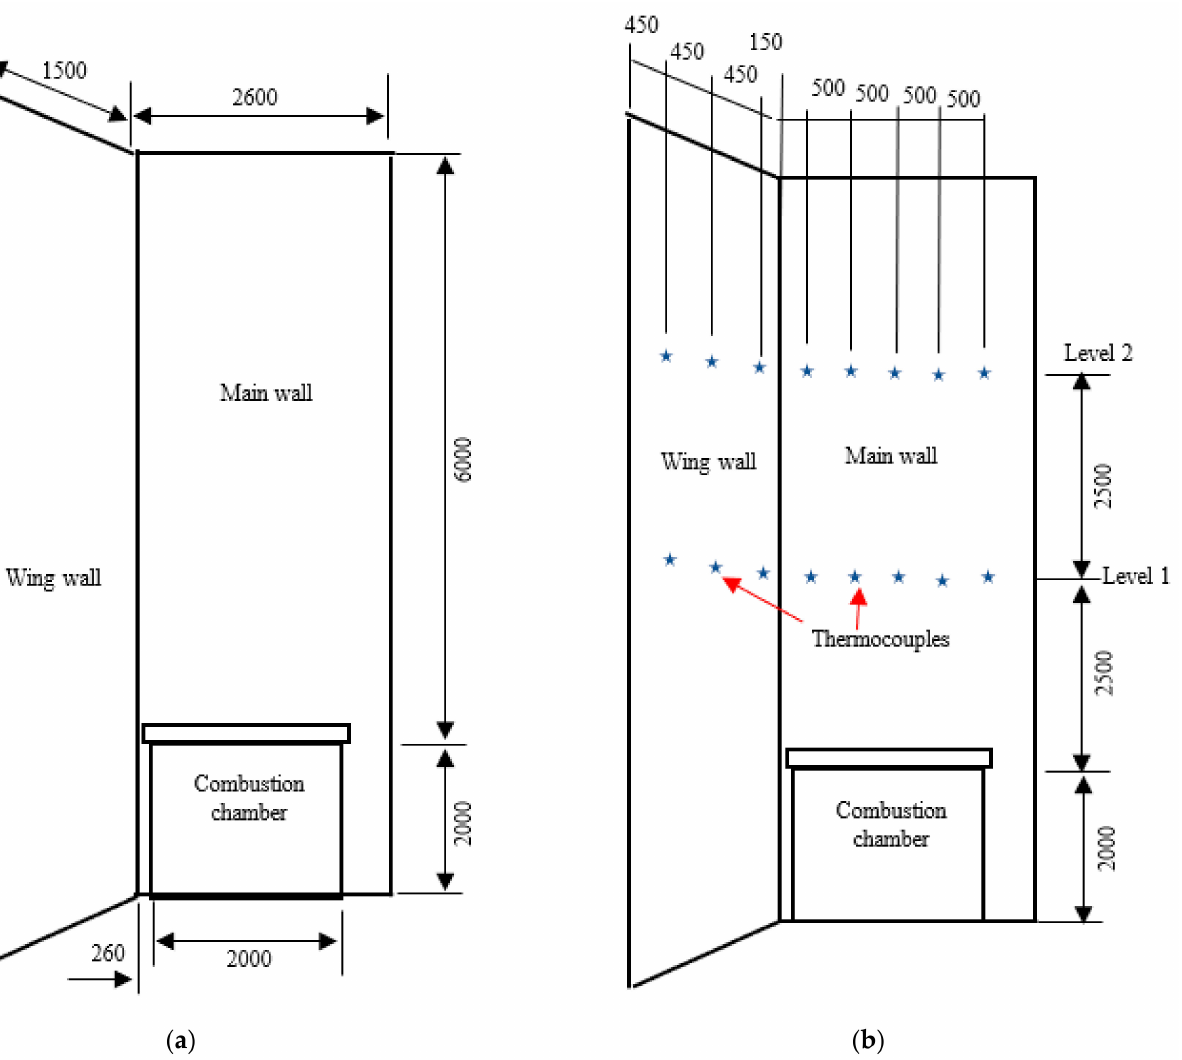
Figure 1a. For the external heat source, a wood crib with an HRR near 3.0 ± 0.5 MW was used in the combustion chamber with dimensions of 1500 mm × 1000 mm × 1000 mm. The DCLG experimental setup, including its k-type thermocouple location details, is shown in Figure 1b and the experimental setup can be found in the DCLG test 1 report [17].